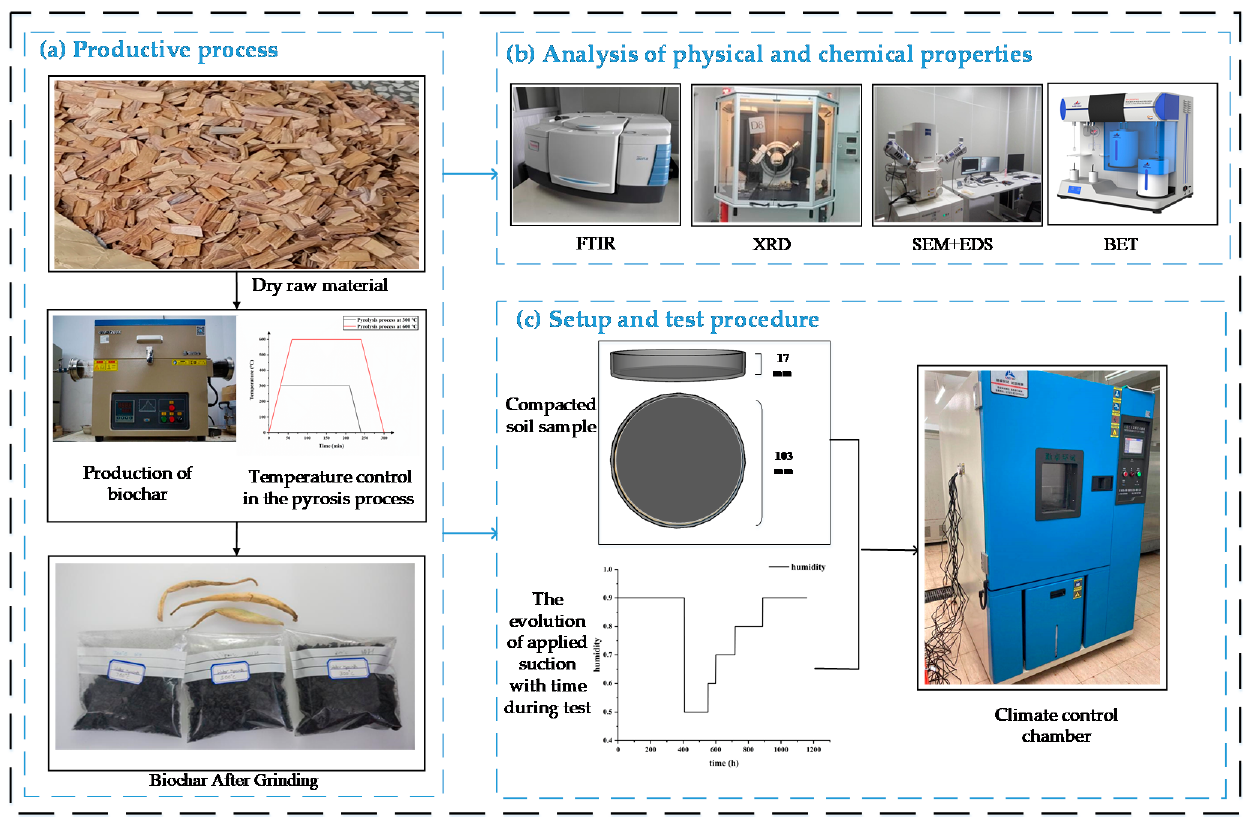
Figure 2. Schematic representation of the objectives of this study.